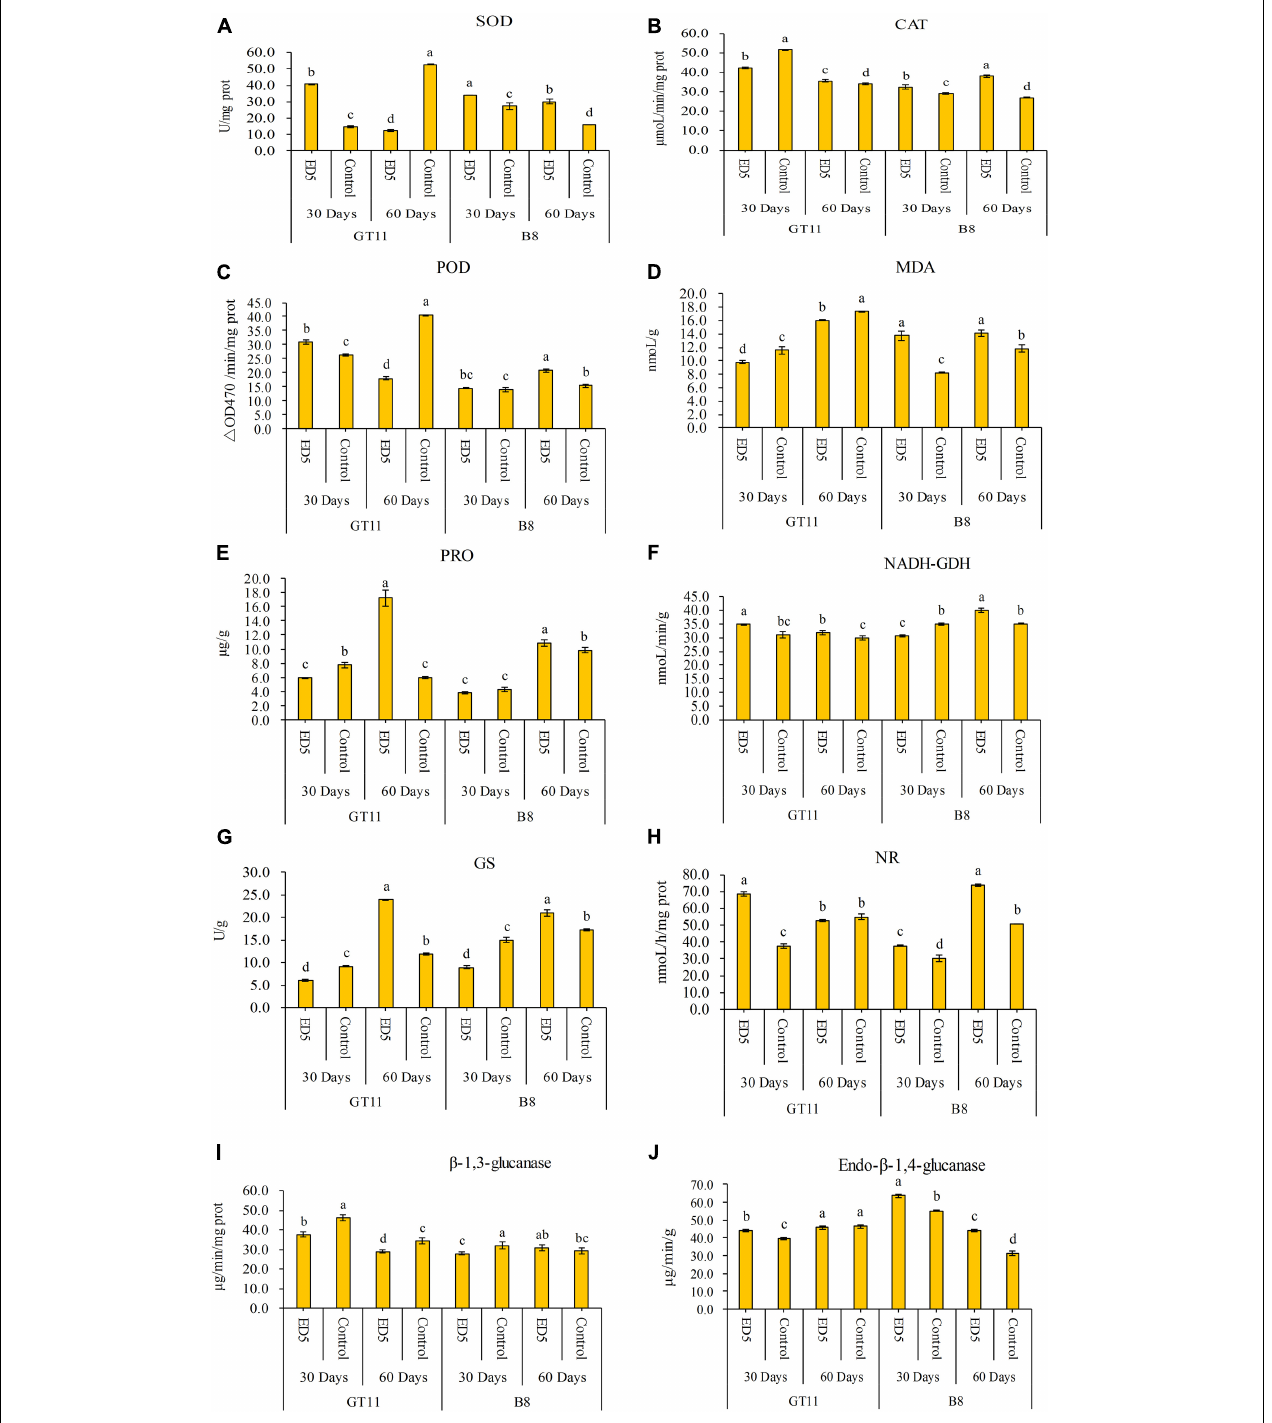
FIGURE 1 | Variations in biochemical parameters in the leaf of sugarcane varieties GT11 and B8 inoculated with E. roggenkampii ED5 as compared to control. (A) Superoxide dismutase (SOD) activity, (B) catalase (CAT) activity, (C) peroxidase (POD) activity, (D) malondialdehyde (MDA) content, (E) proline (Pro) content, (F) NADH-glutamate dehydrogenase (NADH-GDH) activity, (G) glutamine synthetase (GS) activity, (H) nitrate reductase (NR) activity, (I) β -1,3-glucanase ( β -1,3-GA) activity, and (J) endo- β -1,4-glucanase activity. Plant samples were collected at 30 and 60 days after the inoculation. At the level of p < 0.05, different letters indicate significant changes between